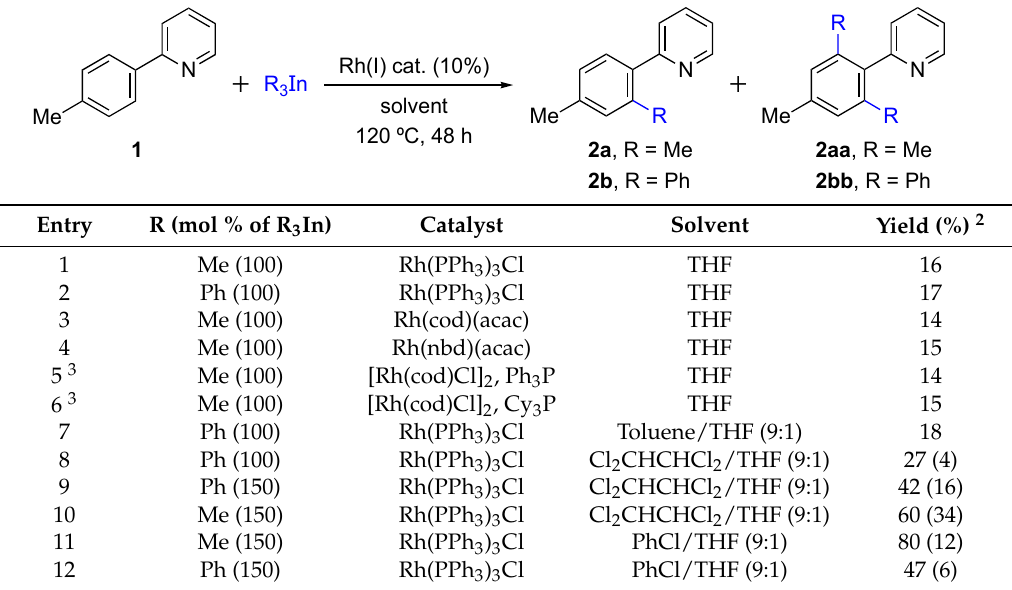
Molecules 2018 , 23 , x FOR PEER REVIEW